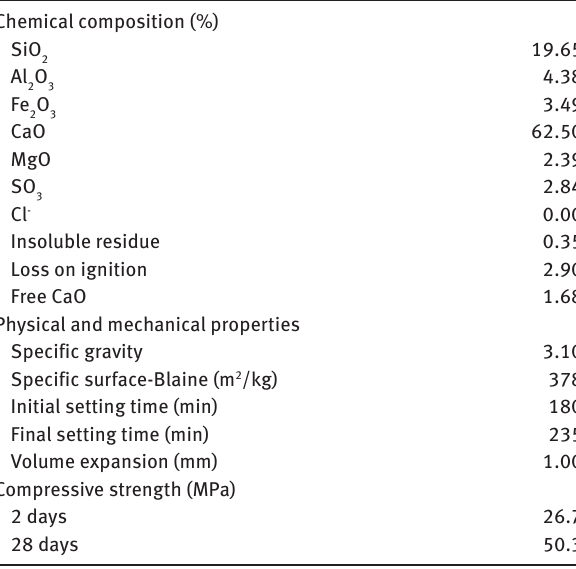
Table 1 Physical, chemical, and mechanical properties of